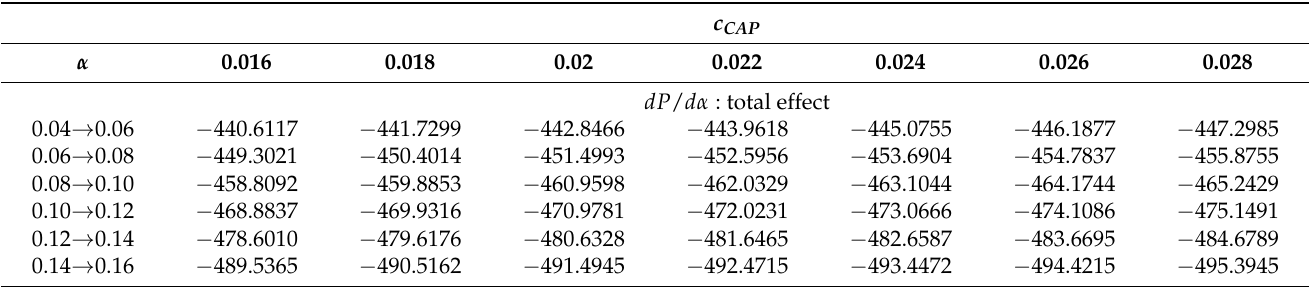
Table 11. Responsiveness of the policyholder protection to the insurer’s leverage at various levels of c CAP